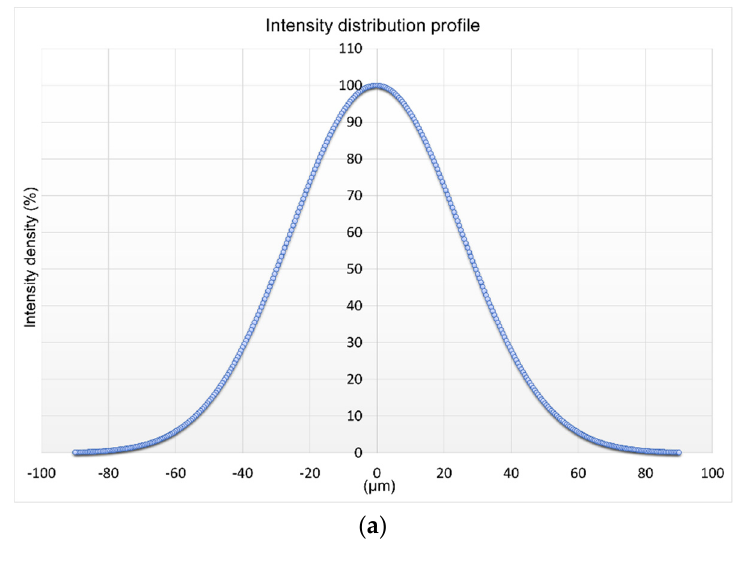
Figure 1. Intensity distribution profile of laser beam ( a ) and beam simulation ( b ) of TruMark 5020 laser equipment.